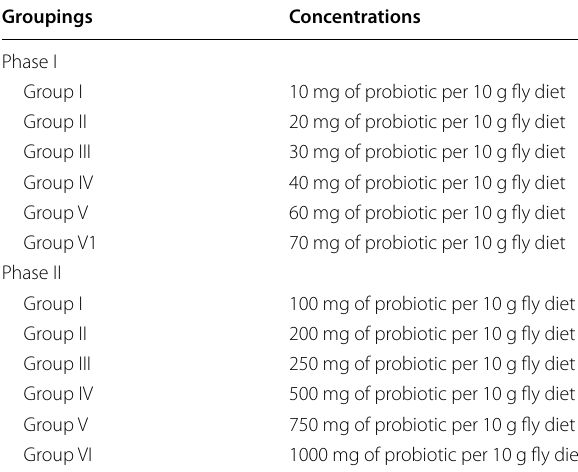
Table 1 Phases of the LC50 in determining the dose of Probiotic to administered to Drosophila